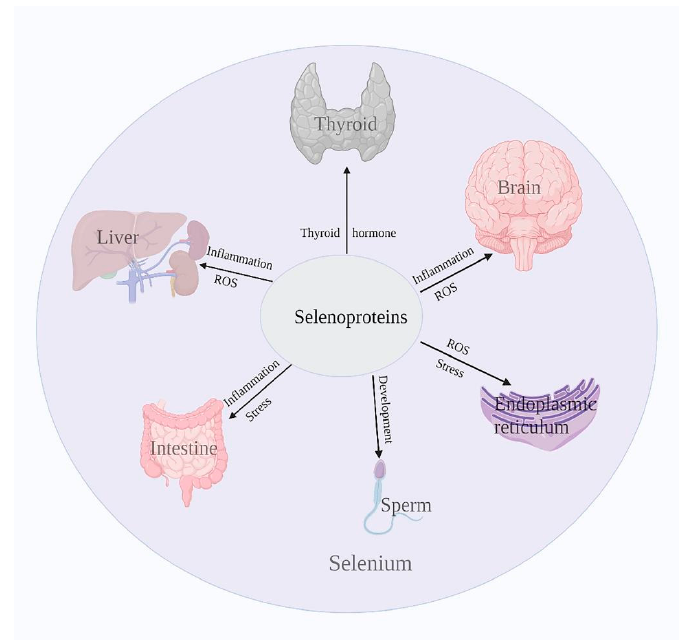
Figure 4. Selenoproteins regulate the health of many organs. Selenoproteins are involved in the regulation of multiple tissues and organs to main ‐ tain homeostasis. DIO can regulate thyroid hormone levels, and decreased plasma levels of the thyroid hormone are associated with increased DIO3 expression. ER ‐ resident pro ‐ teins in selenoproteins can regulate ER oxidative stress and alleviate the damage caused by oxidative stress. Selenoproteins can also regulate intestinal health by regulating the production of reactive oxygen species and inflammatory response, and alleviate the de ‐ velopment of diseases, such as in the nervous system. In addition, selenoproteins are also important in cancer and reproduction. Selenoproteins can affect the maturation process of sperm, which affects sperm motility and thus fertility. Moreover, many studies have shown that selenoproteins are closely involved in the development of cancer. 4. Mechanisms That Show That Selenoproteins Regulate Disease Selenoproteins can be involved in regulating cellular oxidative stress, ER stress, an ‐ tioxidant defense, immune response, inflammatory response and other biological pro ‐ cesses in the body [1,3,22,74], including antioxidant, anti ‐ inflammation, anti ‐ apoptosis, and regulating immune response and other functions. Selenoproteins regulate body health in various and complex ways [5,18,20]. 4.1. Selenoproteins Regulate Immune Responses Immune responses are often closely related to inflammatory processes, and are also associated with ROS production and redox processes [20]. Se and selenoproteins regulate inflammatory and immune processes through redox function [77]. White blood cells, such as lymphocytes, macrophages and neutrophils, require ROS and pro ‐ inflammatory mol ‐ ecules for activation, differentiation and phagocytosis [2]. The production of ROS in ‐ creases the expression of inflammatory cytokines by increasing NF ‐κ B activity. Because selenoproteins may affect these signaling pathways, they are also important in regulating immune responses and inflammation [78 ‐ 80]. SELENOK is essential for calcium flux, T ‐ cell proliferation and neutrophil migration in immune cells and has been shown to protect cells from ER stress ‐ induced apoptosis [34]. Graves’ disease (GD) and Hashimoto’s thy ‐ roiditis (HT) are the most common autoimmune thyroid diseases (AITDs) [77]. Serum Se